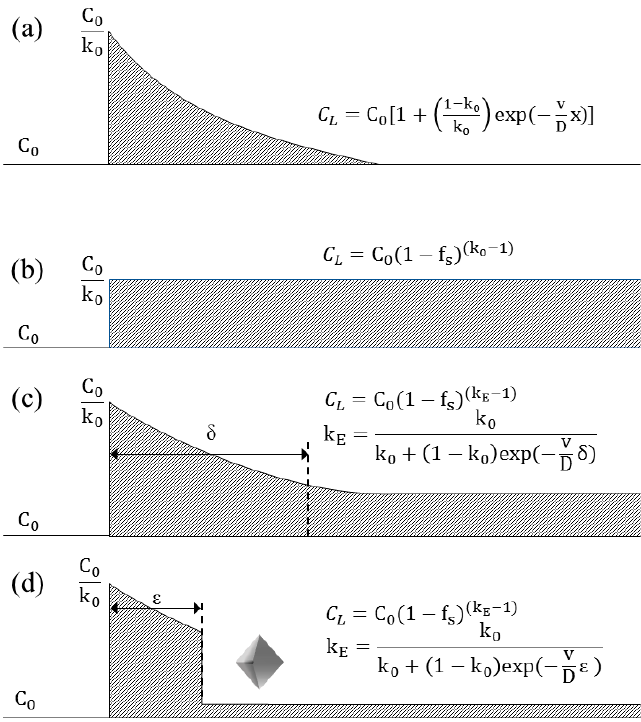
Figure 13. Solute redistribution at the solid/liquid interface: ( a ) Diffusion only, ( b ) convection only, ( c ) both diffusion and convection and ( d ) occurrence of nucleation [33] .